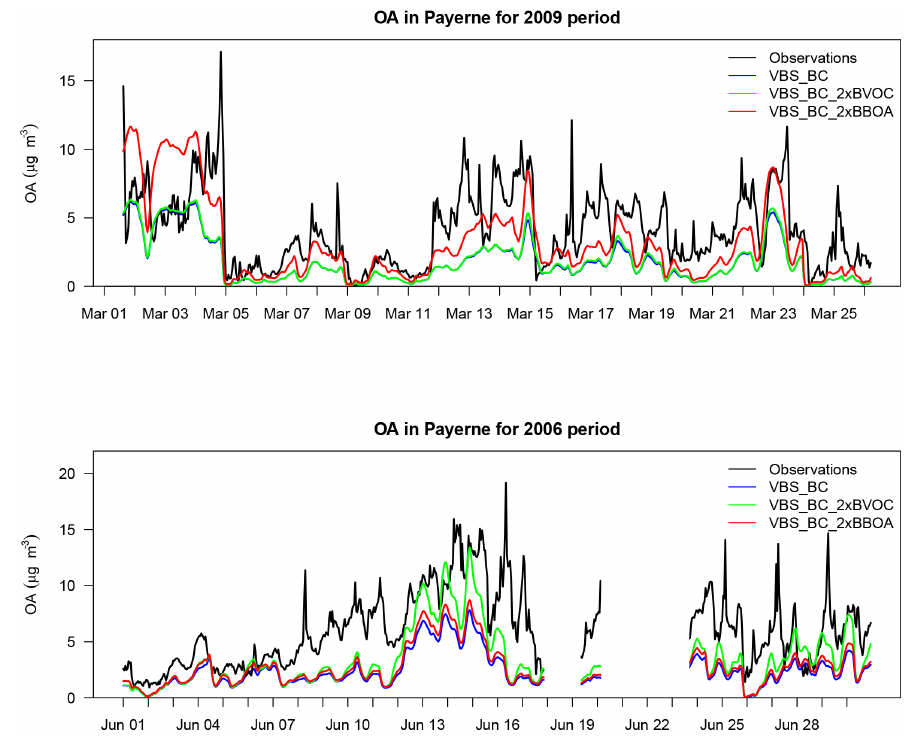
Figure 9. Predicted and observed total OA for scenarios VBS_BC, VBS_BC_2xBVOC and VBS_BC_2xBBOA in March 2009 (upper panel) and June 2006 (lower panel) at